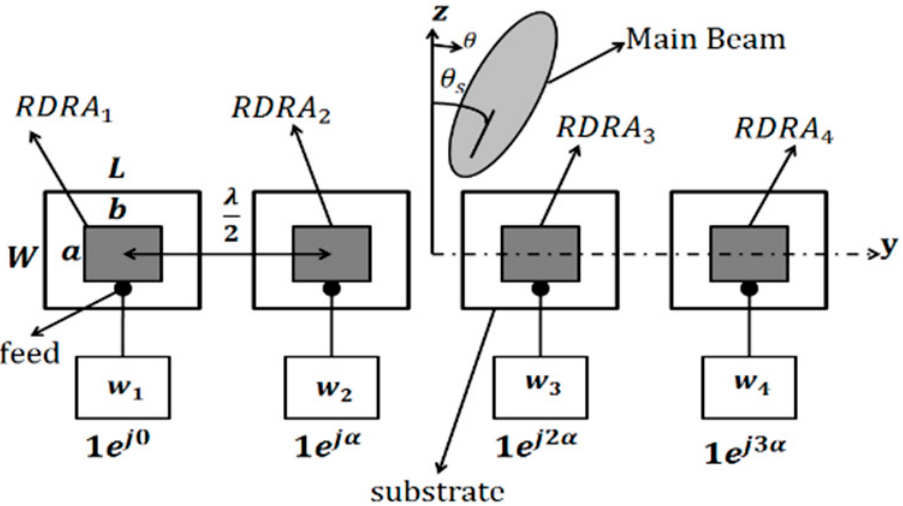
Figure 1. Schematic of the four-element scanning RDRA array.